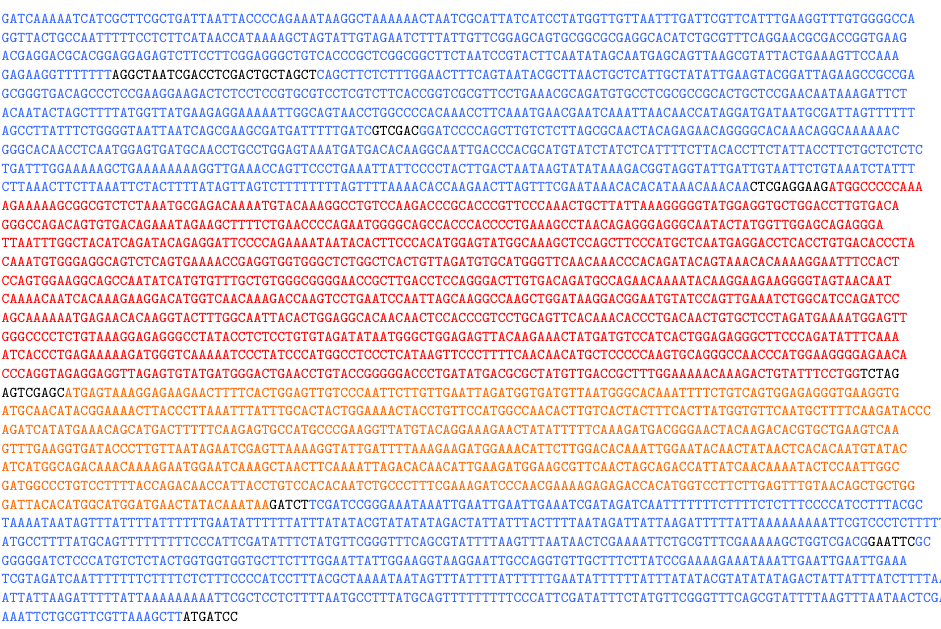
Figure 3: Sequence of the pGUL2-VP1-GFP expression cassette showing the duplicated upstream GAL1/10 UAS fragments (blue), the first (357 bp) in GAL1-GAL10 orientation and the second (353 bp) inverted. These are followed by the pGDH fragment (388 bp, also blue) completing the hybrid promoter. The reading frame for strain BG VP1 (1152bp, red) is fused to GFPbex (915 bp, orange) and the two tPGK terminator segments (314 and 381 bp, blue) complete the cassette, as shown schematically in Figure